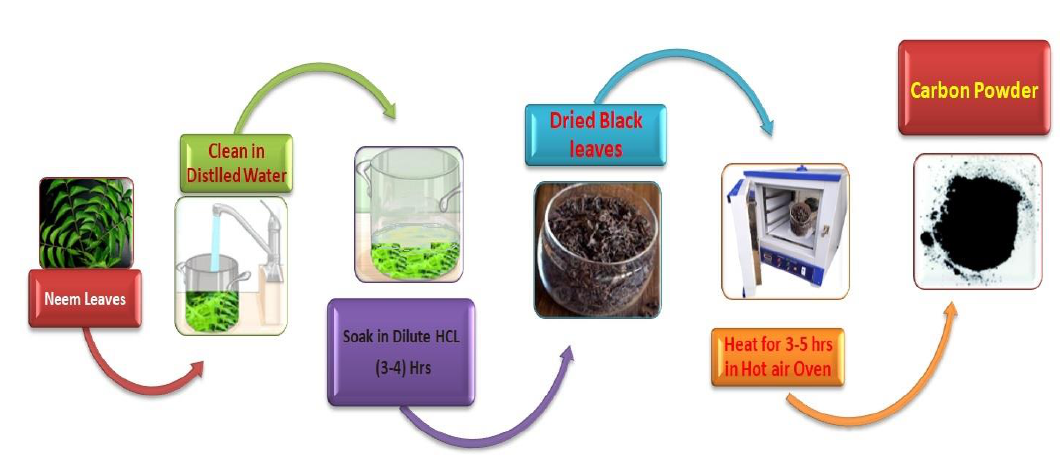
Fig.2 Process cycle of synthesis of Carbon